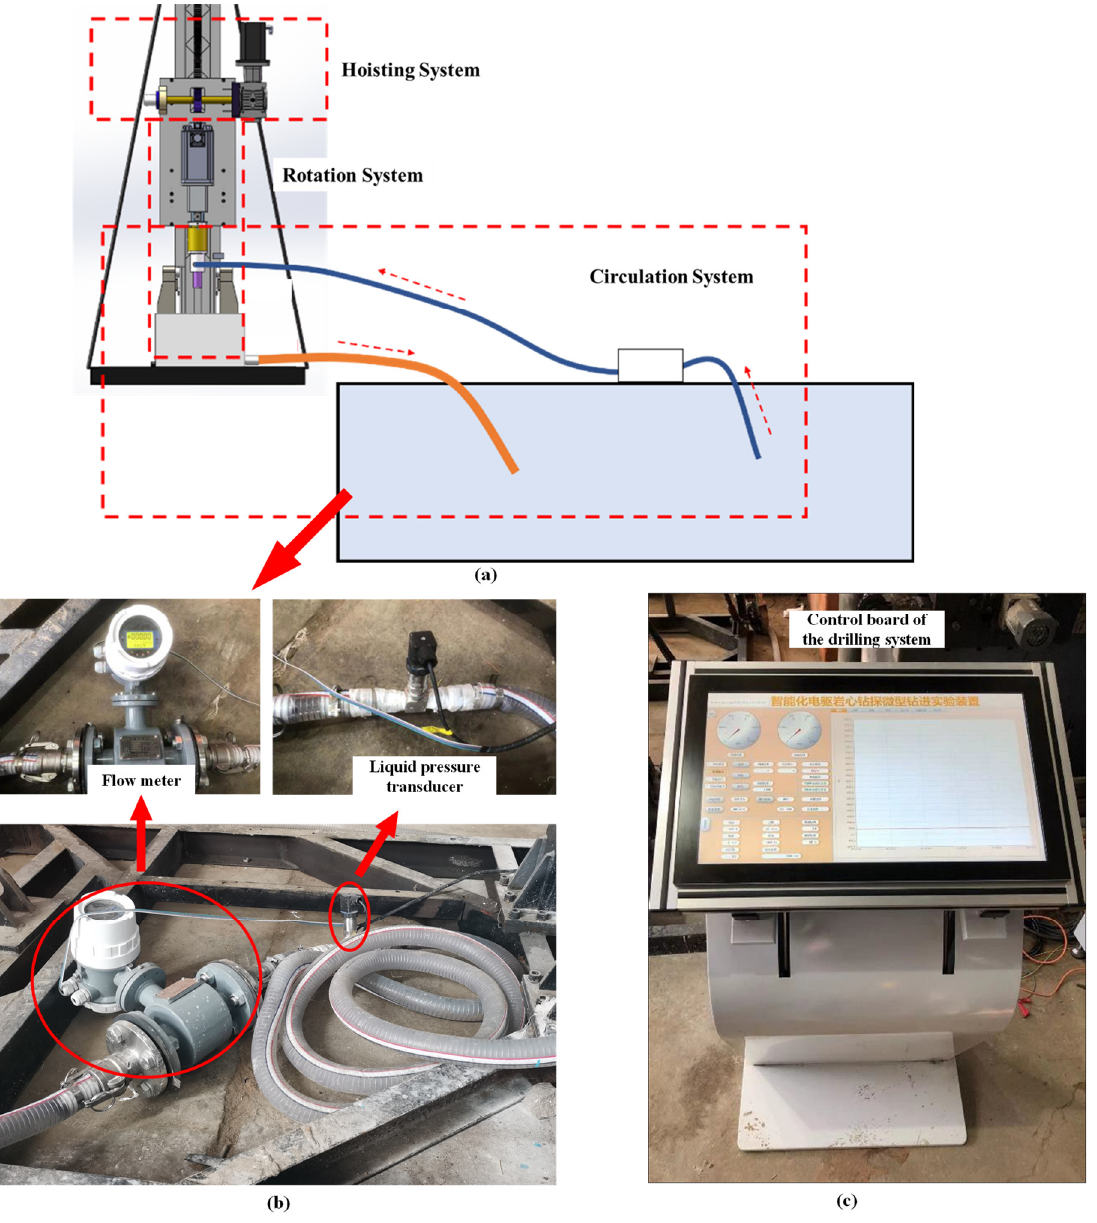
Figure 3. ( a ) Physical drawing of the automatic electric drive drilling system, ( b ) two sensors in the circulation system, ( c ) the control board of the automatic electric drive drilling system. The servo controller can use analog voltage signals to control the RPM and the torque from the top drive. The signals were transmitted from programmable logic controllers (PLCs) to the servo